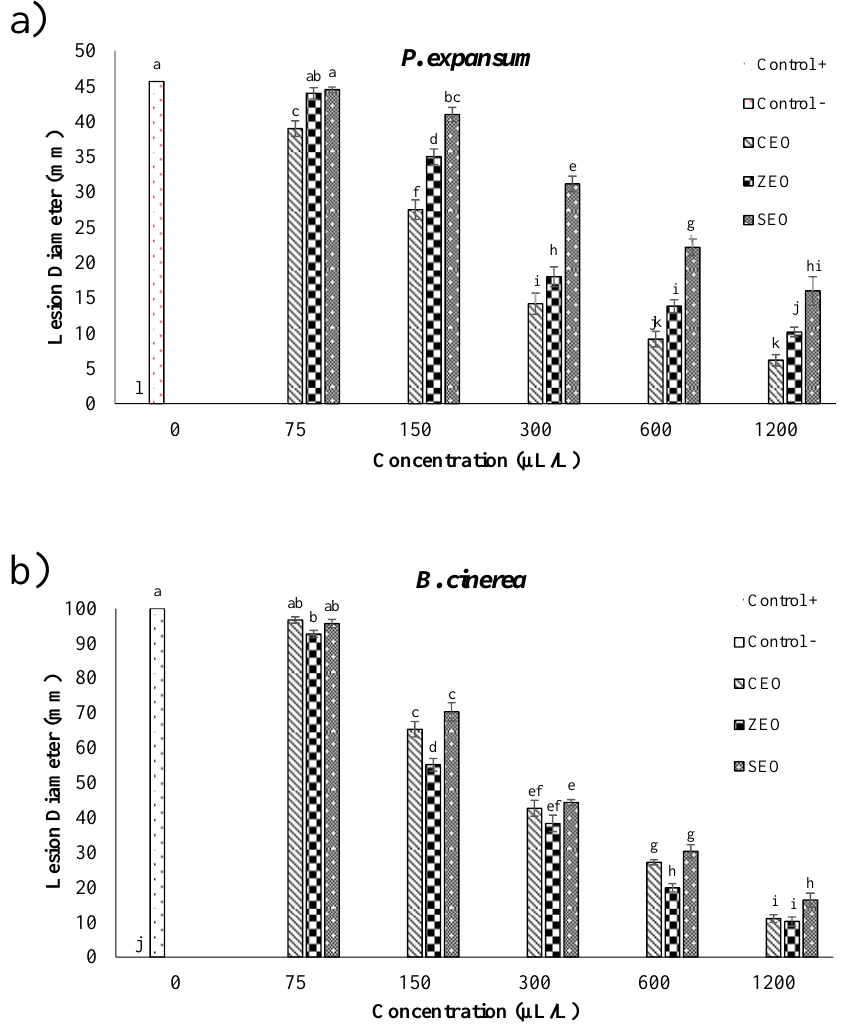
Figure 2. Effect of CEO, ZEO, and SEO treatments at different concentrations (75 – 1200 μ L/L) against P. expansum ( a ) and B. cinereal ( b ), artificially inoculated into apple fruit (in vivo), after 21 days of storage at 25 °C. Each lesion diameter is an average of 15 replicates. Different letters above the bars denote a statistically significant difference according to the Tukey test ( p < 0.05).